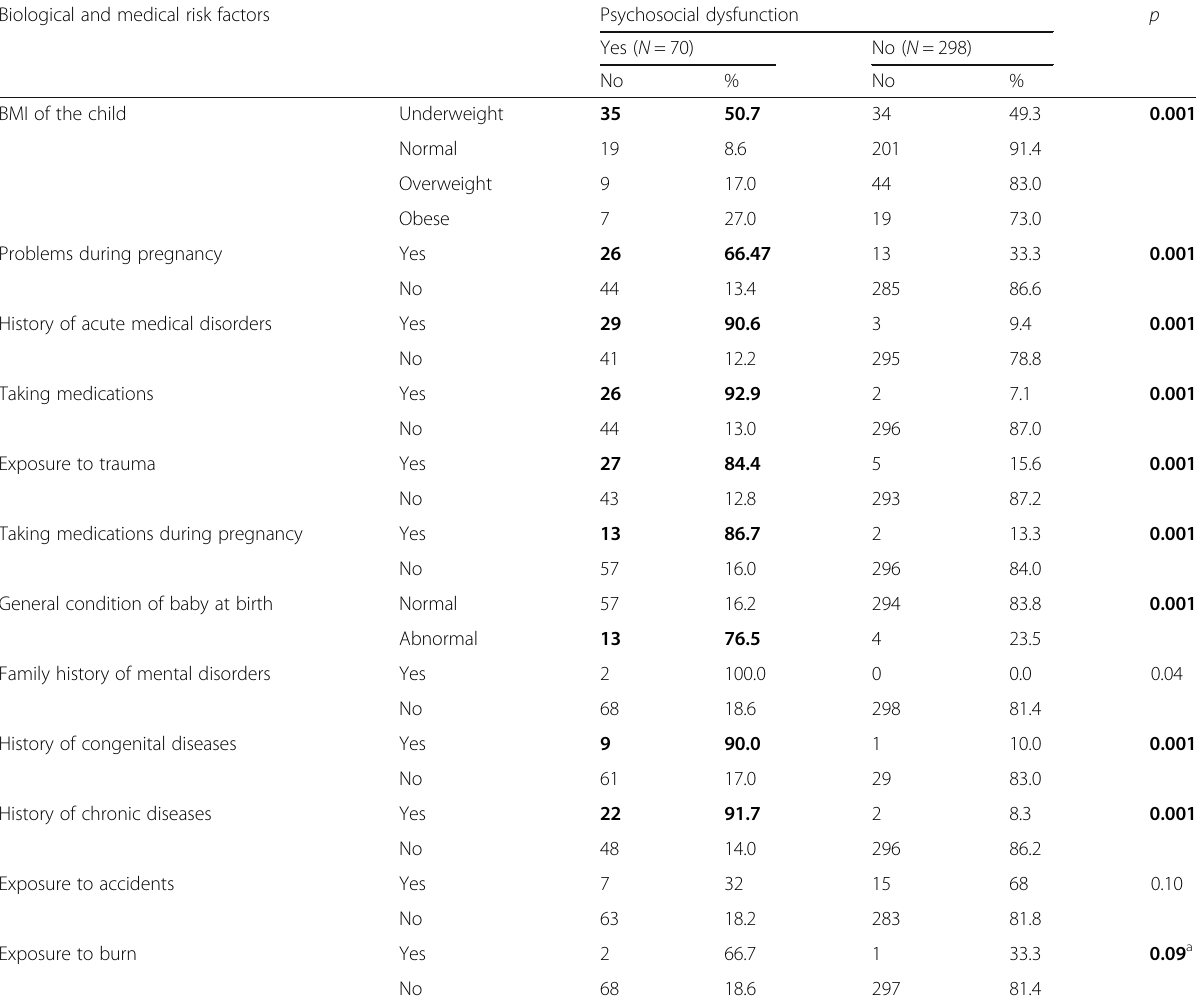
Table 5 Association between biological and medical risk factors of the studied group and CPD Biological and medical risk factors